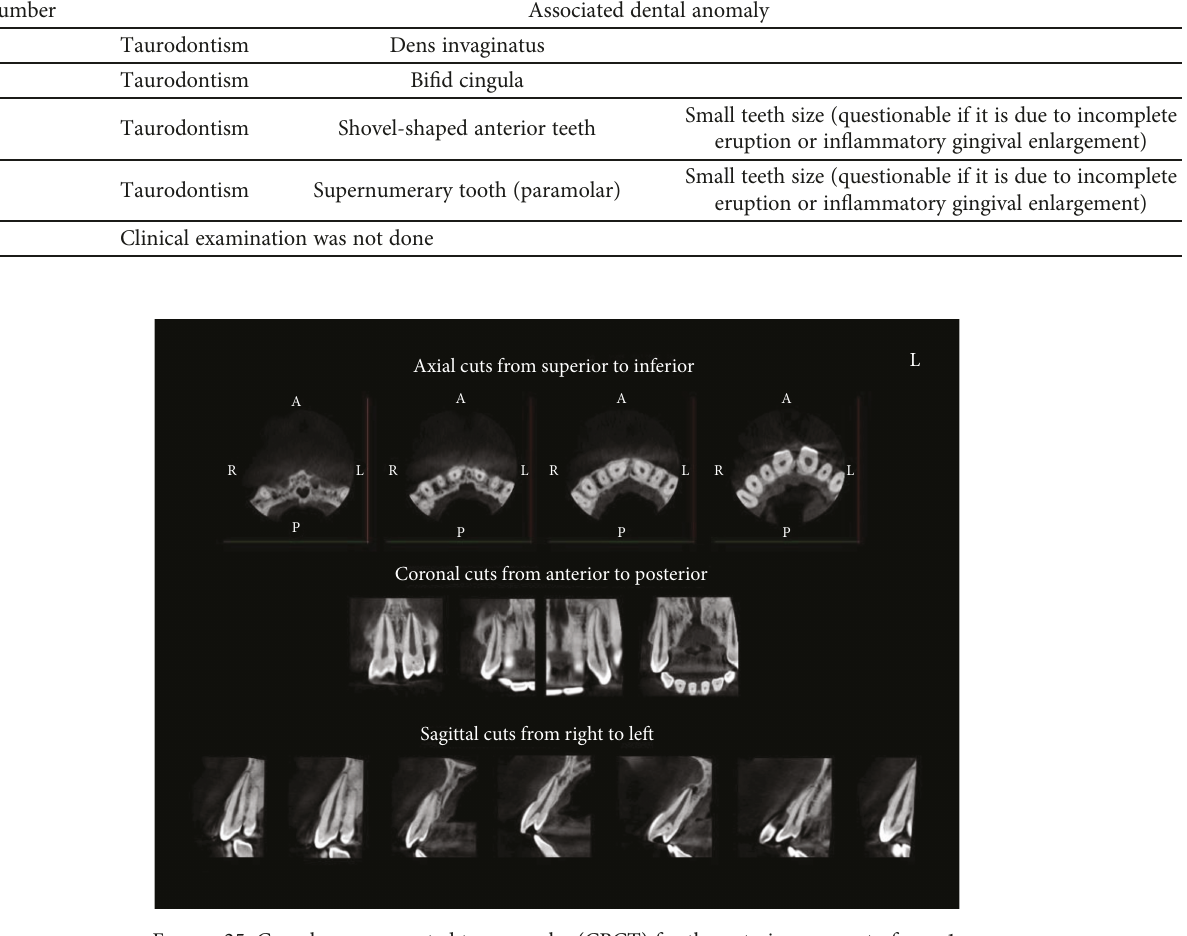
Figure 25: Cone beam computed tomography (CBCT) for the anterior segment of case